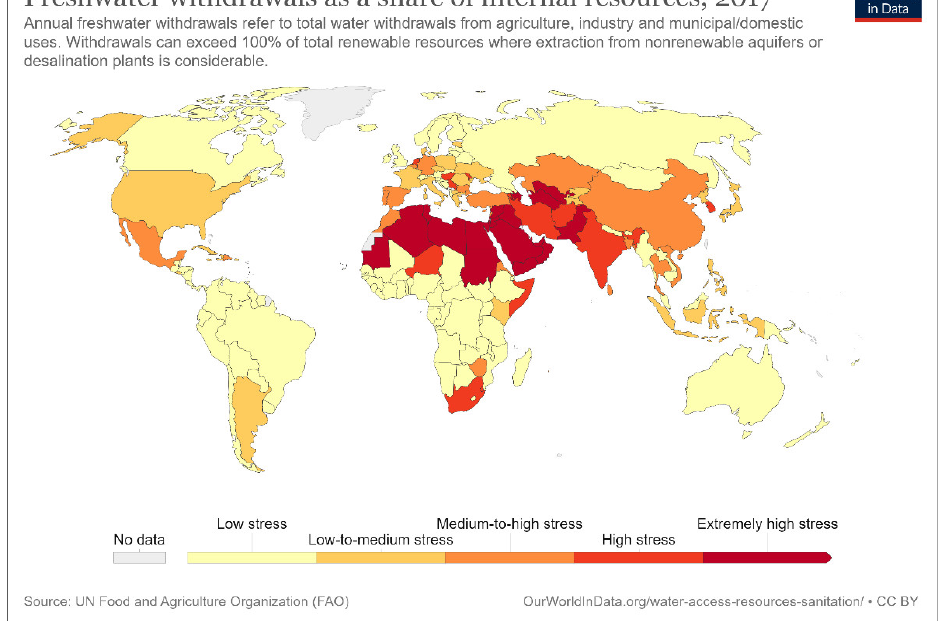
Figure 1. Freshwater withdrawals as a share of internal resources, 2017 [5].